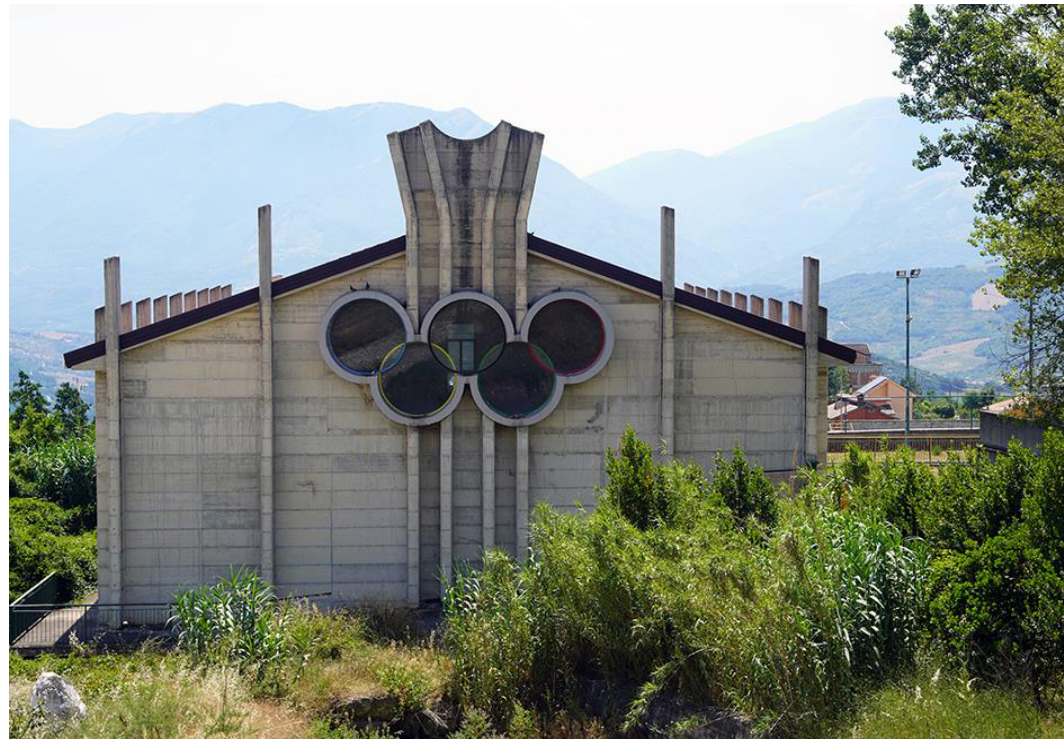
Figure 7. Castelnuovo di Conza: the new sports hall (photos by [35,36]).